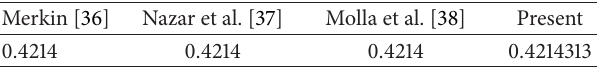
Table 1: Comparison of −𝜃 󸀠 ( 0 ) for free convection along a vertical flat plate in Newtonian fluid when 𝑁 = 0, 𝑛 = 0, B = 0, Pr = 1, Bi → ∞ , and 𝑓 𝑤 =